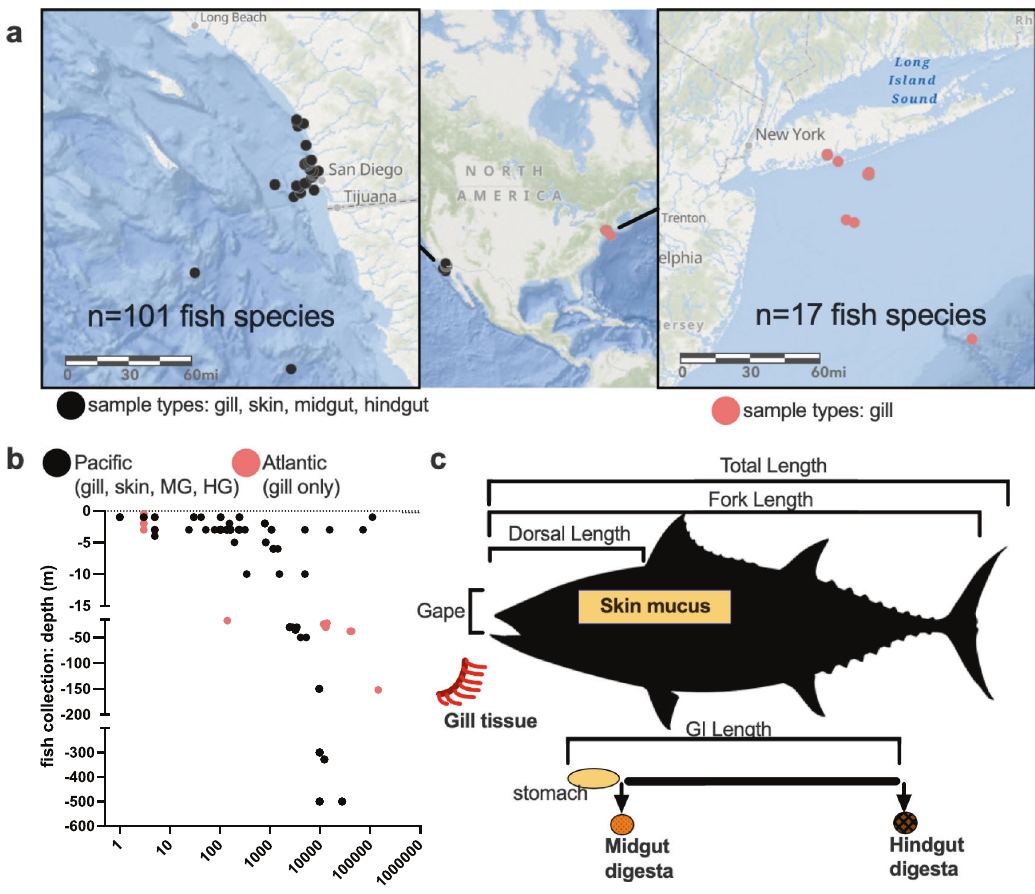
Fig.1|Samplingdesignof116speciesofmarine fi sh.a UsingArcGIStodepictthe general area from which fi sh were sampled: black dots indicate the locations of the 101 unique species of marine fi sh sampled from the California Current Eco- system in the Eastern Paci fi c Ocean primarily in the waters of San Diego CA. Red circles depict the locations of an additional 17 species of fi sh (15 unique species with 2 species duplicates) collected from the Western Atlantic primarily in the waters of New York. When multiple species of fi sh were caught in the same location, a single circle is used to indicate the location. b Fish were sampled across a gradient of depth and distances from shore. c Biometric measurements